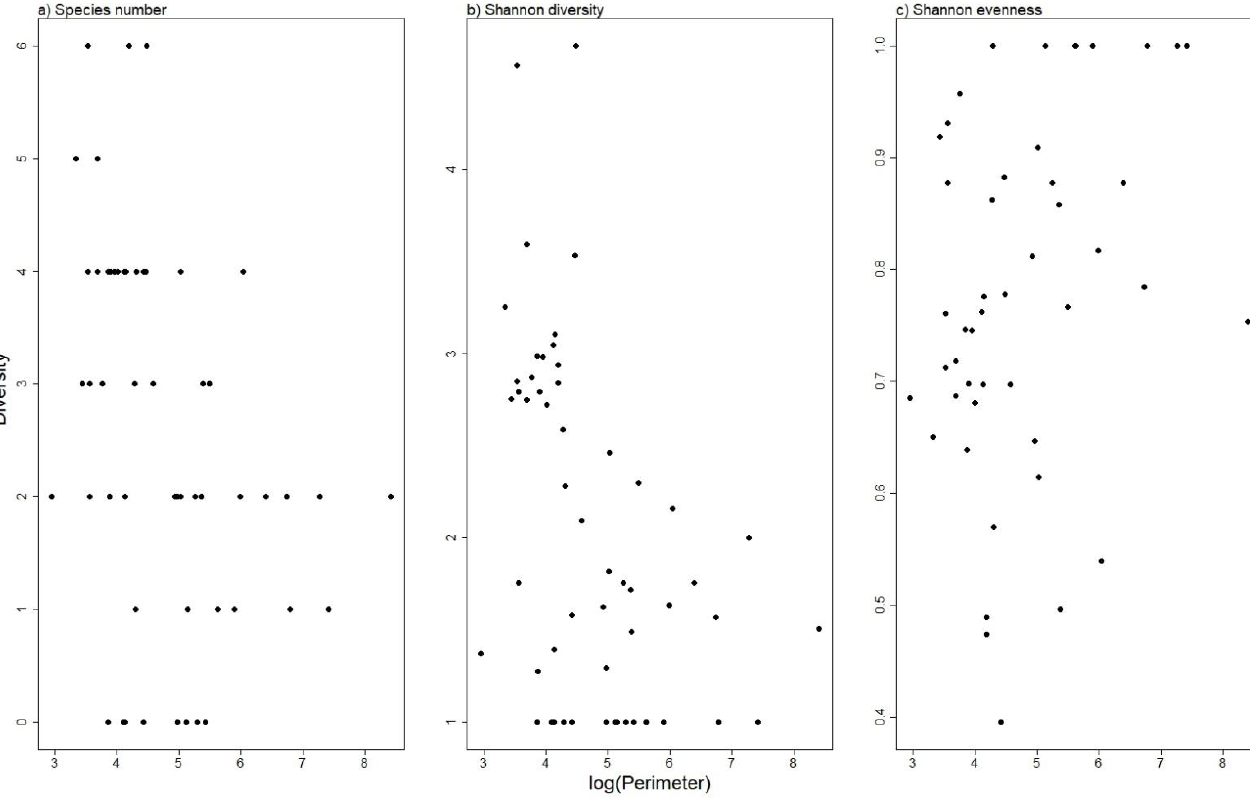
Figure 4. Relationship between diversity and shoreline length in aquatic beetle communities in Faroese ponds. Species richness ( a ), Shannon diversity ( b ), and Shannon evenness ( c ) are shown in relation to log-transformed shoreline length (pond perimeter). Table 3. Dependence of diversity indices on environmental variables. The adjusted r 2 value shows the variance explained by the linear models. Slope (b), standard error (SE), t -values, and p -values are shown for variables in the minimal adequate models for species richness, Shannon diversity, and Shannon evenness.